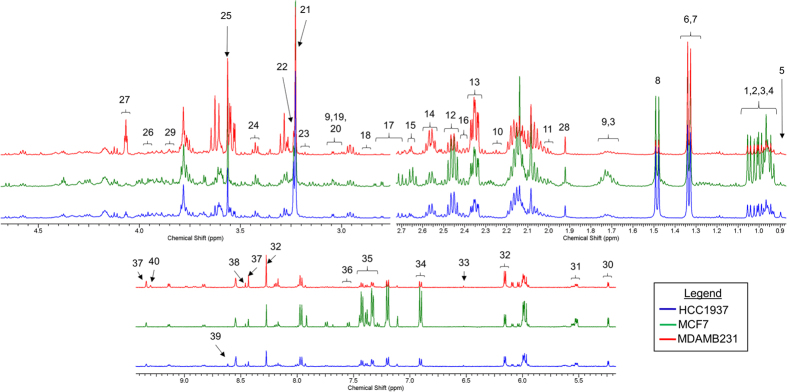
Representative NMR spectra for annotated peaks of intracellular metabolites.1: Isoleucine, 2: Valine, 3: Leucine, 4: 2-oxoisocaproate, 5: Pantothenate, 6: Lactate, 7: Threonine, 8: Alanine, 9: Lysine, 10: 2-aminoadipate, 11: Proline, 12: Glutamine, 13: Glutamate, 14: Glutathione, 15: Methionine, 16: Pyroglutamate, 17: Aspartate, 18: Asparagine, 19: Creatine, 20: Creatine phosphate, 21: O-phosphocholine, 22: Sn-glycero-3-phosphocholine, 23: Beta-alanine, 24: Taurine, 25: Glycine, 26: Serine, 27: Myo-inositol, 28:Acetate, 29: Sorbitol, 30: Glucose, 31: UDP-GlycNac, 32: ATP, 33: Fumarate, 34: Tyrosine, 35: Phenylalanine, 36: Tryptophan, 37: NAD+, 38: Formate, 39: AMP, 40: 1-methylnicotinamide.